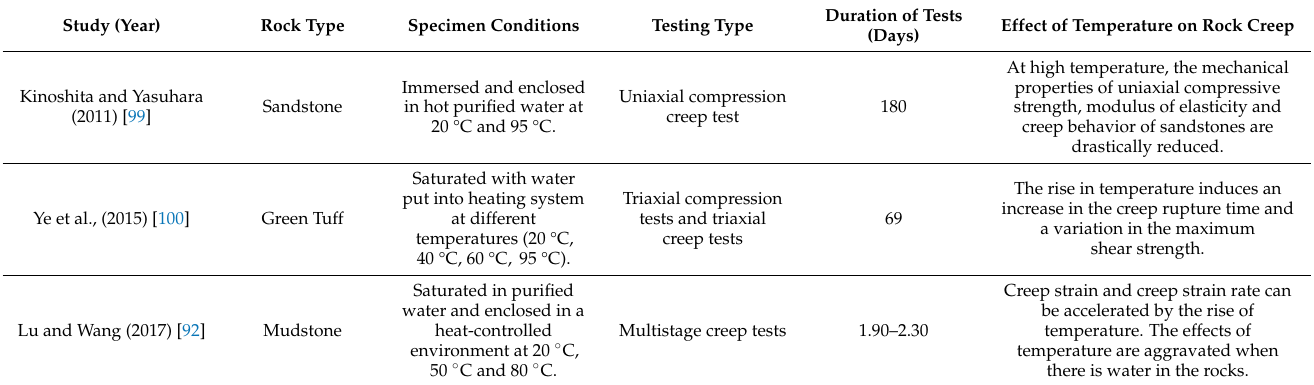
Table 2. Summary of the effects of temperature on the creep behavior of rocks. Data are taken into account given that the rock samples were mainly collected from deep rock tunnels, and also because of the available relevant studies. The maximum duration or duration range of the tests is provided to better understand the